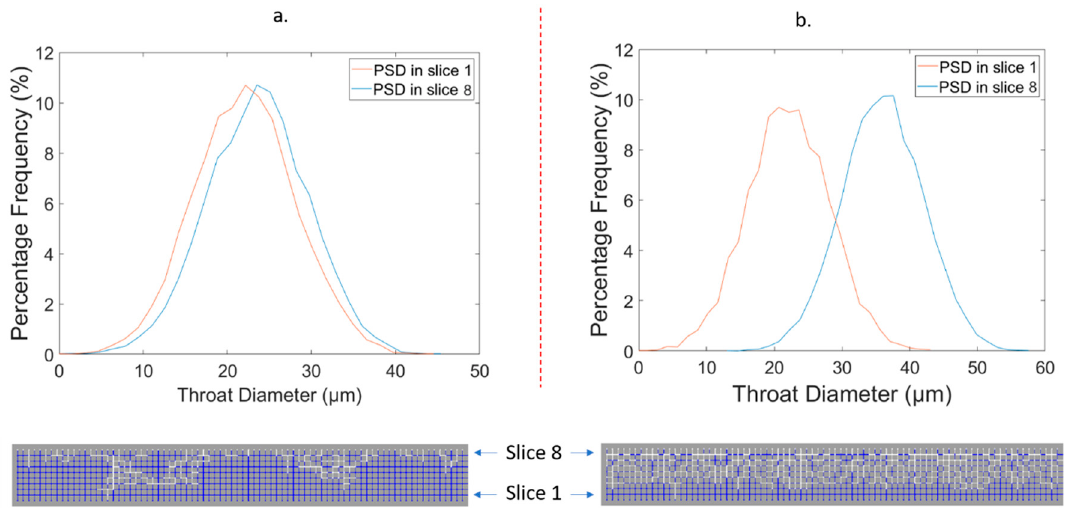
Figure 6. Impact of the height of the gradient on invasion patterns in the example of a 2D simulation: ( a ) pore network with dr / dz = − 2e − 3 ; ( b ) pore network with dr / dz = − 0.02. Shown are slices 1 (brown) and 8 (blue). PSD denotes pores size distribution.